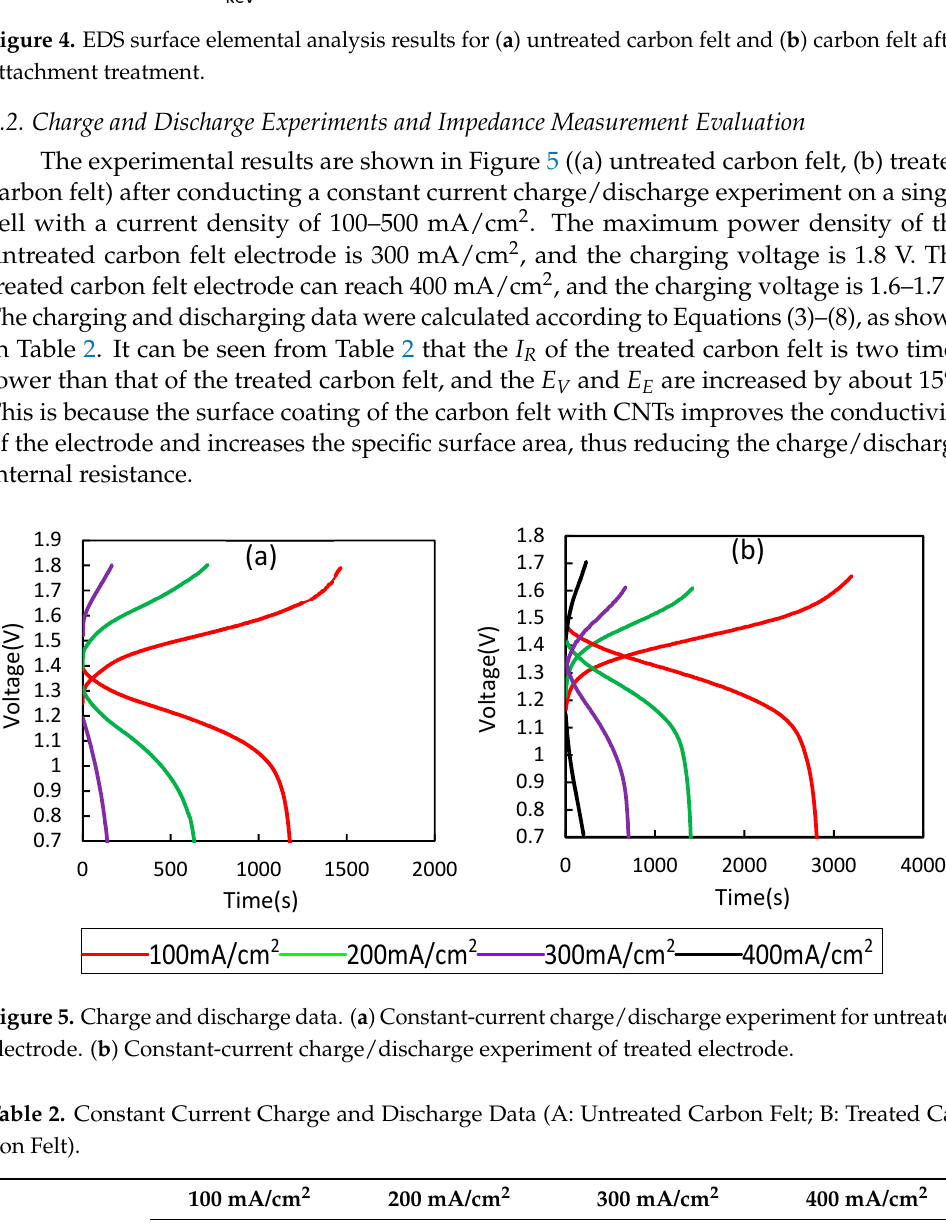
Figure 4. EDS surface elemental analysis results for ( a ) untreated carbon felt and ( b ) carbon felt after attachment treatment. Table 1. EDS Surface Element Analysis Results Comparison.